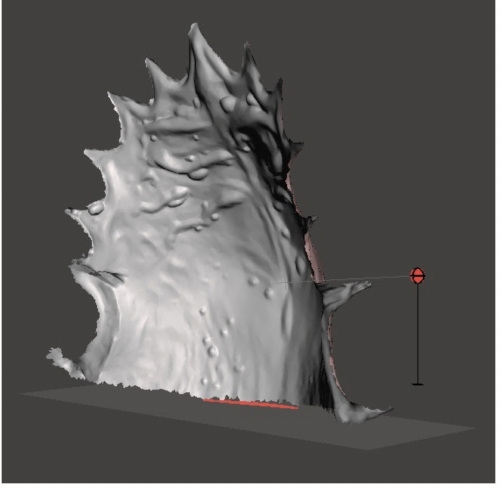
Figure 3. The palatal surface separated from entire model. Data obtained from analysis of pre-treatment and post-treatment models of all the patients in both groups were appropriately collected and subjected to statistical